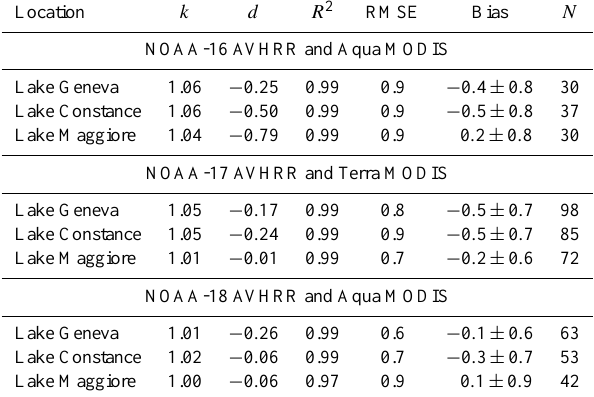
and biases between − 0.5 and 0.2 K. AVHRR-based LSWTs tend to be slightly warmer than MODIS-based temperatures with a slope between 1.0 and 1.06. The inter-comparison be-